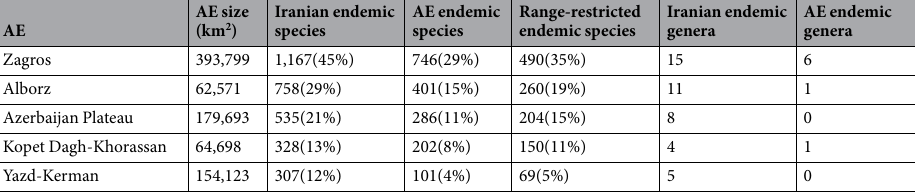
Table 5. Vascular plant endemism in the areas of endemism in